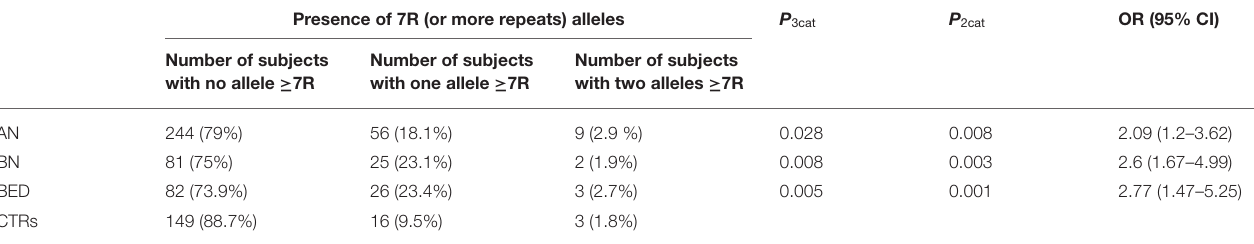
TABLE 3 | Analysis of DRD4 -48 bp VNTR: comparison of the frequency of 7 or more repeats ( ≥ 7 R) alleles in cases (AN, BN, and BED) and healthy controls (CTRs).